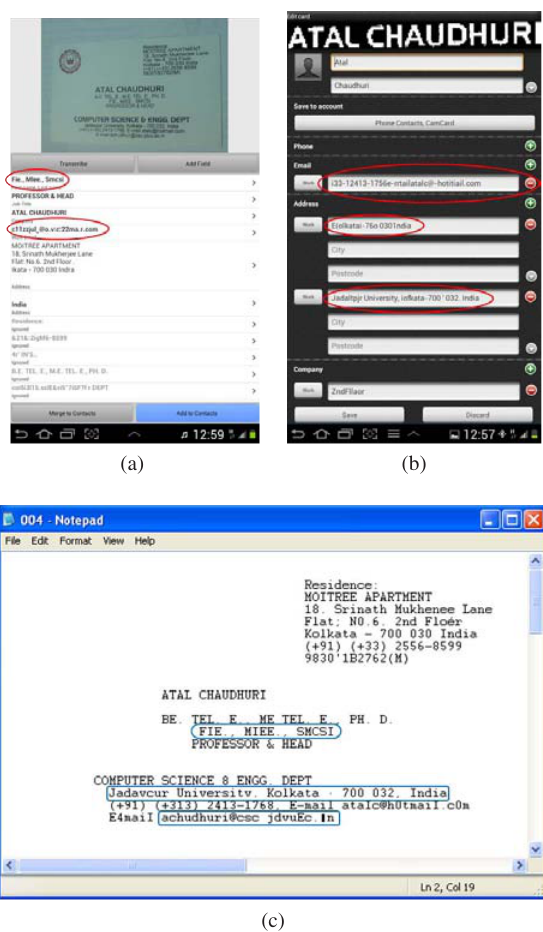
Figure 10. Comparison of recognition results obtained by different techniques. (a) ScanBizCard. (b) CamCard. (c) Proposed technique. Red color denotes incorrect recognition, whereas blue color denotes almost completely correct